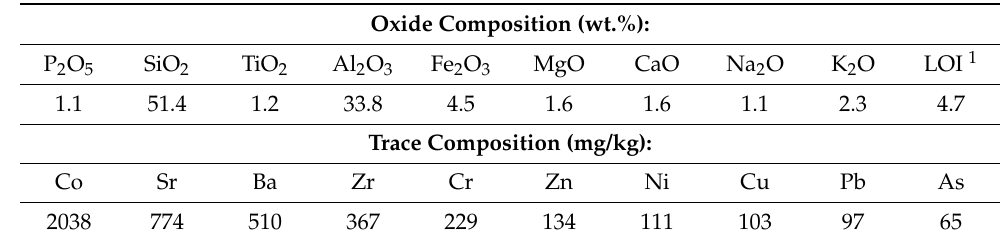
Table 2. The chemical composition of fly ash (FA). Oxide Composition (wt.%):